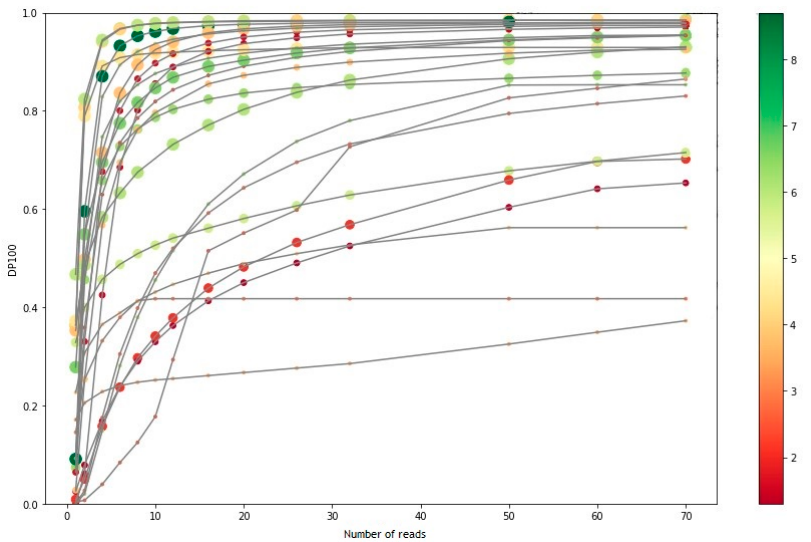
Figure 2. Graphical representation of the DP100 (fraction of bases covered at >100 × ) of different samples versus their respective number of readings.